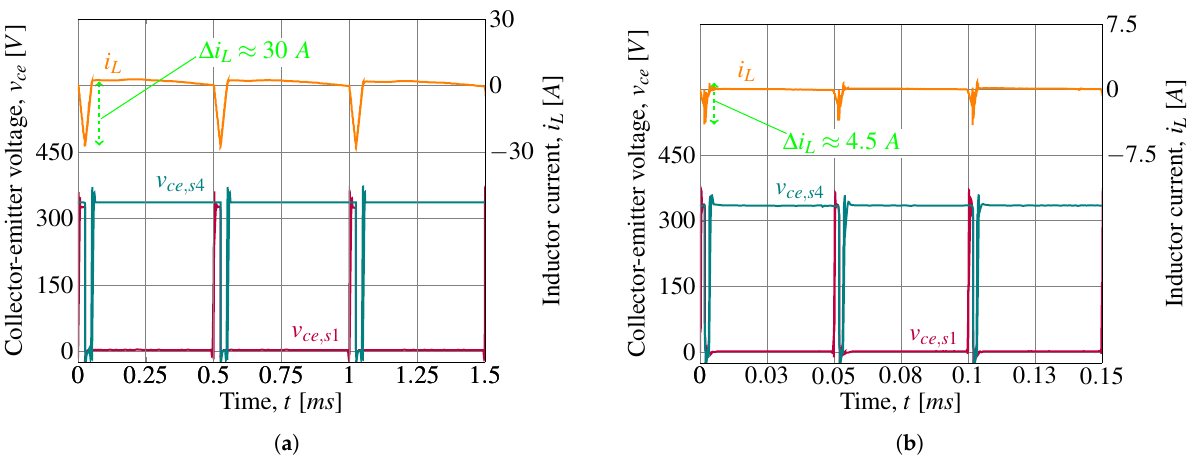
Figure 17. Characteristics for the inductor current ripple and voltages on switches S 1 and S 4 : ( a ) con- verter characteristics for input and output voltages of 330 V with 2 kHz and an output current of 30 A; ( b ) converter characteristics for input and output voltages of 330 V with 20 kHz and an output current of 30 A.